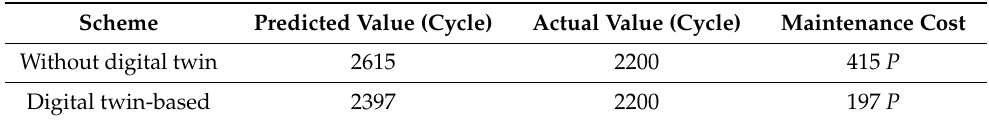
Table 11. Life prediction and maintenance cost analysis of L6